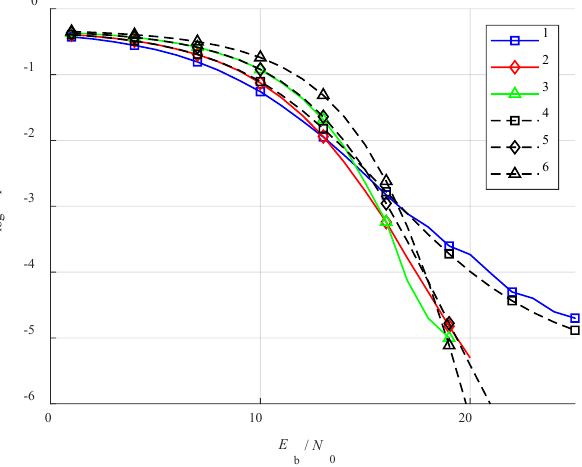
Figure 9. Bit error probability as a function of E b / N 0 at the processing gain K = 50, 100, 200 (curves 1, 2, 3 respectively); solid lines correspond to simulation, and dashed lines (curves 4, 5, 6) to analytical estimates.